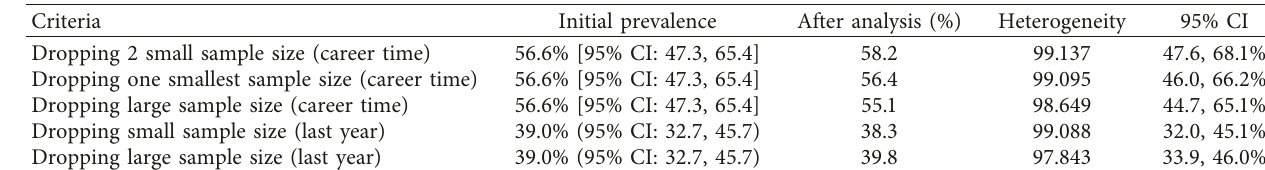
Figure 9: Prevalence of career time occupational exposure to blood and body fluids among healthcare workers based on WHO regions. Table 2: Sensitivity analysis by dropping small sample size and large sample